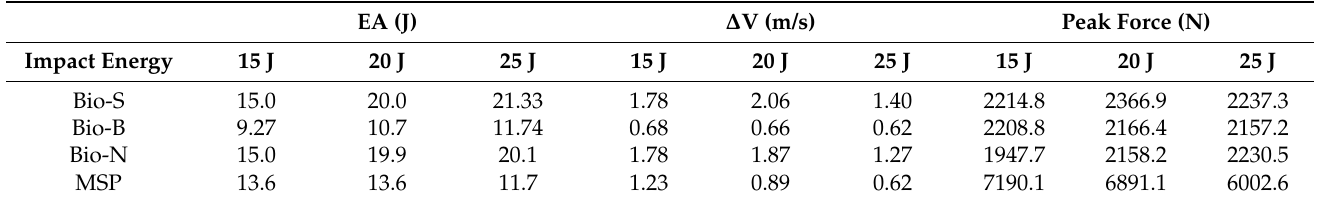
Table 2. EA, ∆ V and peak force for each bionic composite plate under different impact energy